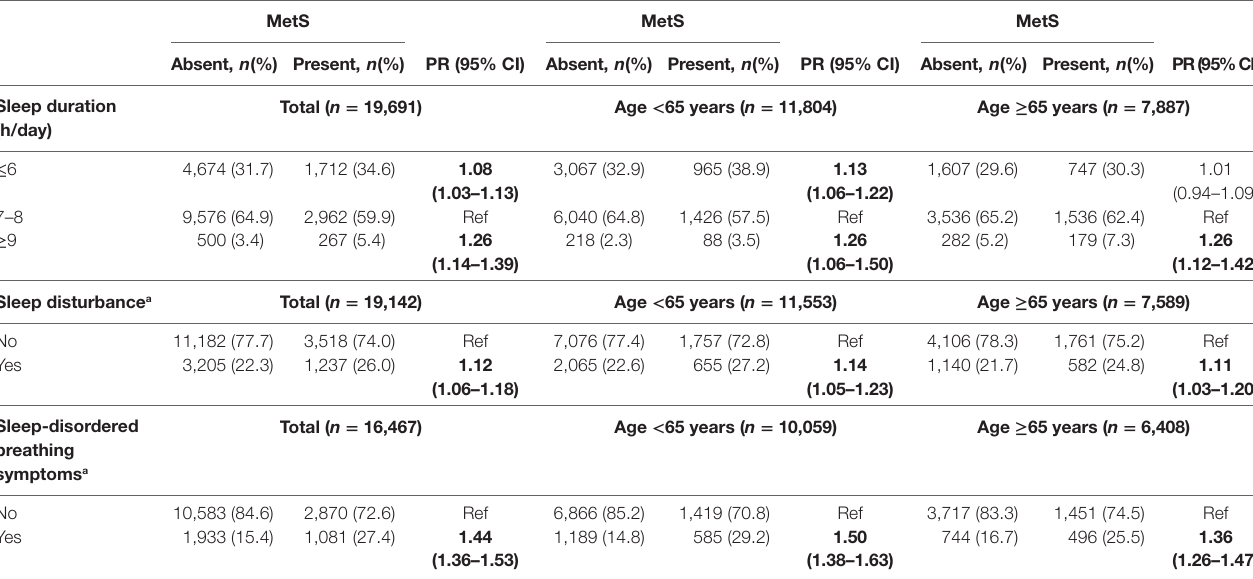
TaBle 2 | Associations between sleep variables and metabolic syndrome (MetS) in the Swedish EpiHealth cohort study. Mets Mets Mets absent, n (%) Present, n (%) Pr (95% ci) absent, n (%) Present, n (%) Pr (95% ci) absent, n (%) Present, n (%) Pr (95%